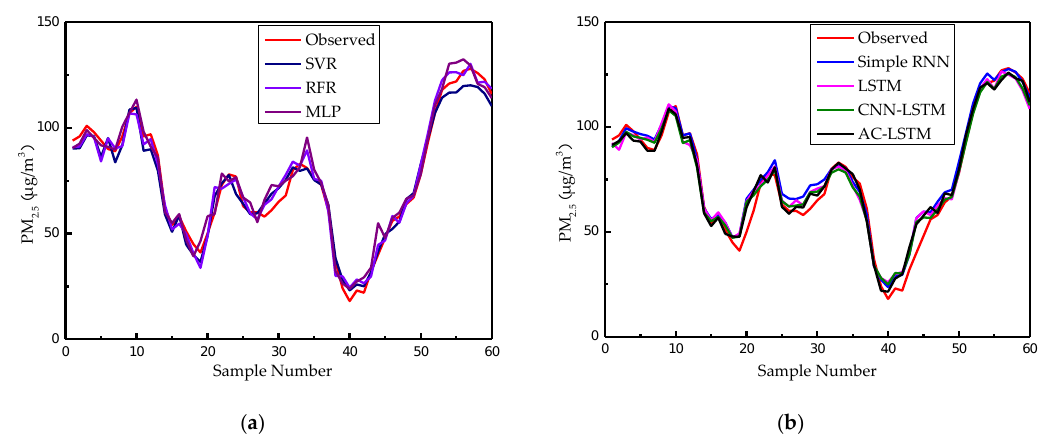
Figure A1. The results of all models in the one-hour PM 2.5 prediction: ( a ) SVR, RFR, and MLP; ( b ) simple RNN, LSTM, CNN–LSTM, and AC-LSTM.